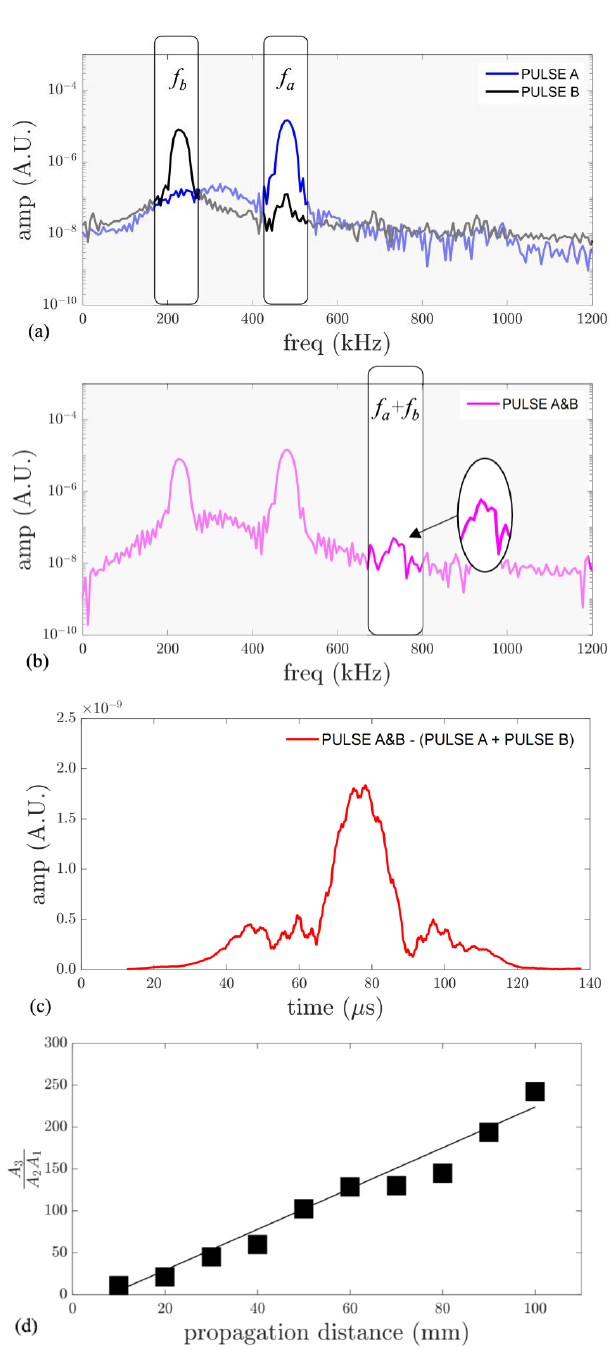
Figure 6. ( a ) Frequency spectra when pulses are excited separately, ( b ) frequency spectra when pulses are excited simultaneously, ( c ) extracted nonlinear wavefield, and ( d ) experimental cumulative behavior of the secondary wave.